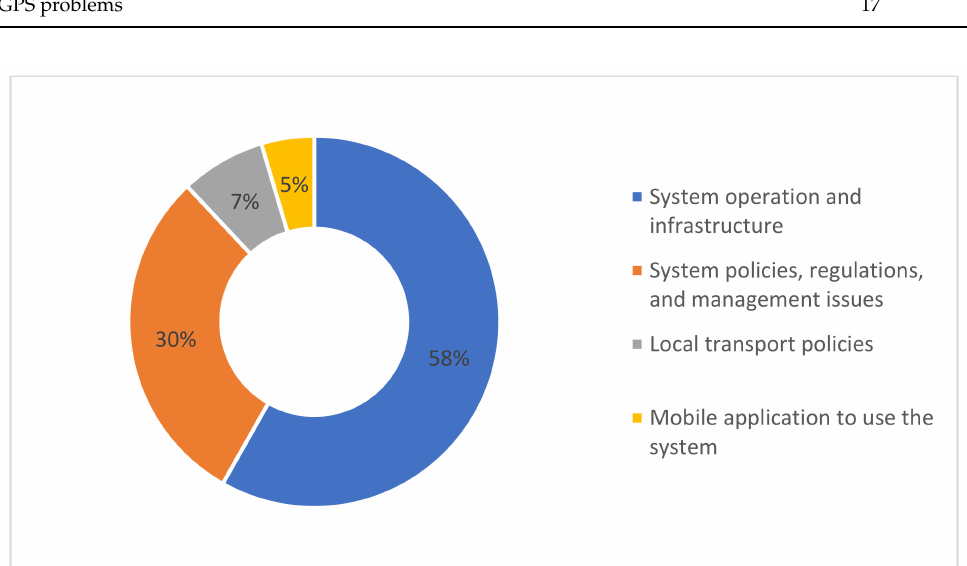
Figure 2. Percentage distribution of complaints areas in car-sharing